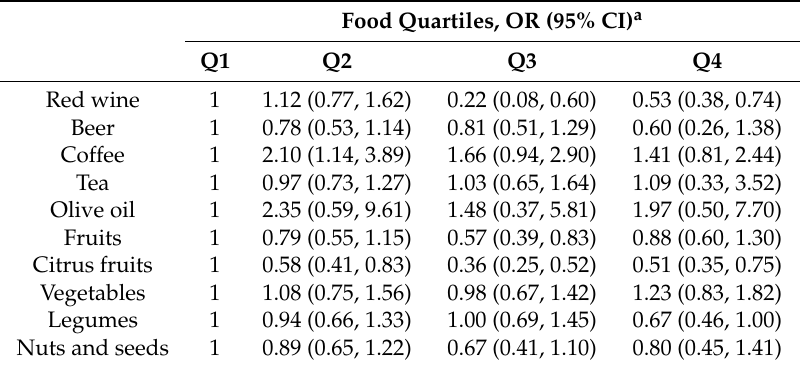
Table 5. Odds ratios (ORs) a and 95% confidence intervals (CIs) for the association between selected major food sources of polyphenols and depressive